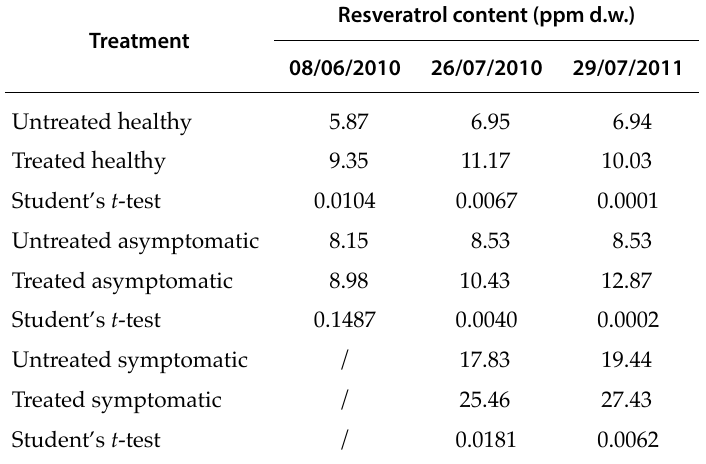
Table 7. Mean Trans -resveratrol level in leaves of treated and untreated vines in the Trebbiano d’Abruzzo vineyard in 2010 and 2011 following treatement with the full mixture CaCl 2 , Mg(NO 3 ) 2 and sea weed extract. Data were compared by the Student t -test ( P